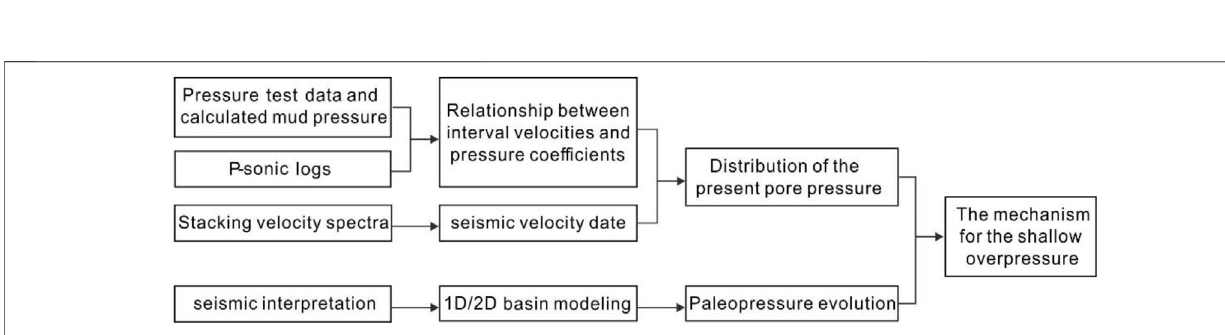
Frontiers in Earth Science |